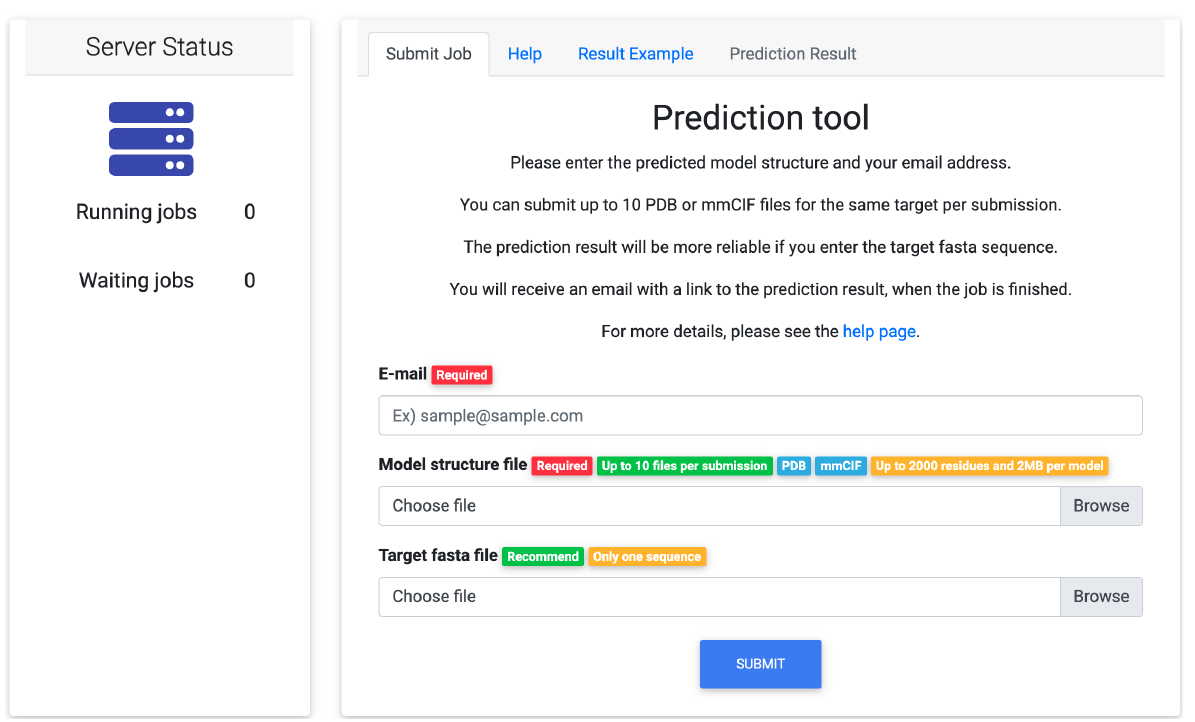
Figure 2. The input page of the web tool. The email address and the model structure in PDB format or mmCIF format are required inputs, and the sequence in FASTA format is an optional input. You can check the number of running jobs and the number of waiting